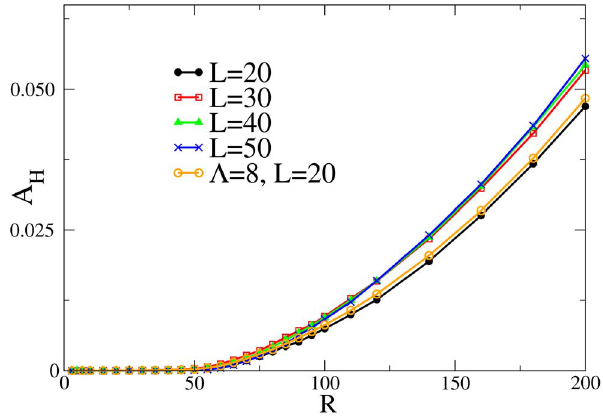
Figure 3. Resulting area in hypoxia for one blocking spot of radius R . Each curve has a different diffusion length, L ~ 20, 30, 40 and 50 (each point in the graphic represents the average of 500 runs). Also shown are the results for L ~ 20 with L ~ 8 . The curves for different L and L ~ 20 are, essentially, undistinguishable. In all cases the radius of the circle necessary for an average hypoxia region larger than zero